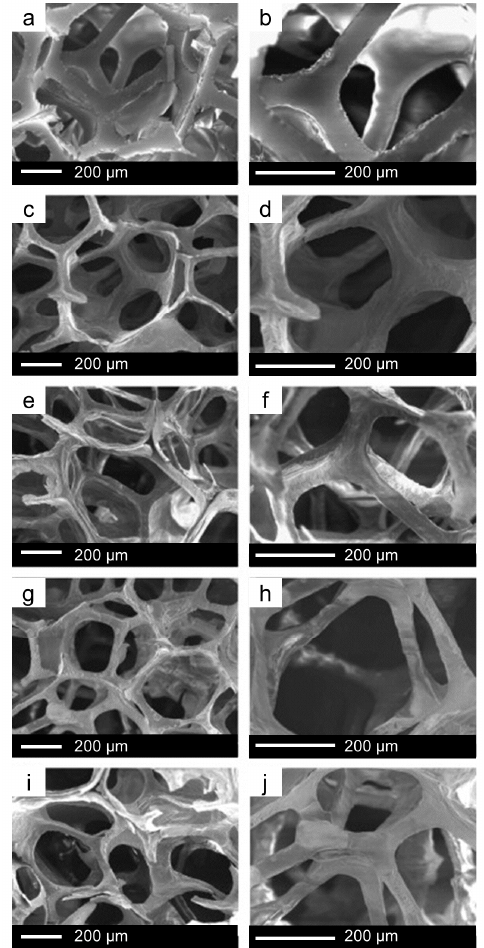
Figure 13. SEM analysis of polyurethane sponges ( a , b ) and macro-mesoporous scaffolds with composition (mol.%) 100SiO 2 ( c , d ), 90SiO 2 –5CaO–5P 2 O 5 ( e , f ), 80SiO 2 –15CaO–5P 2 O 5 ( g , h ), and 70SiO 2 – 25CaO–5P 2 O 5 ( i , j )